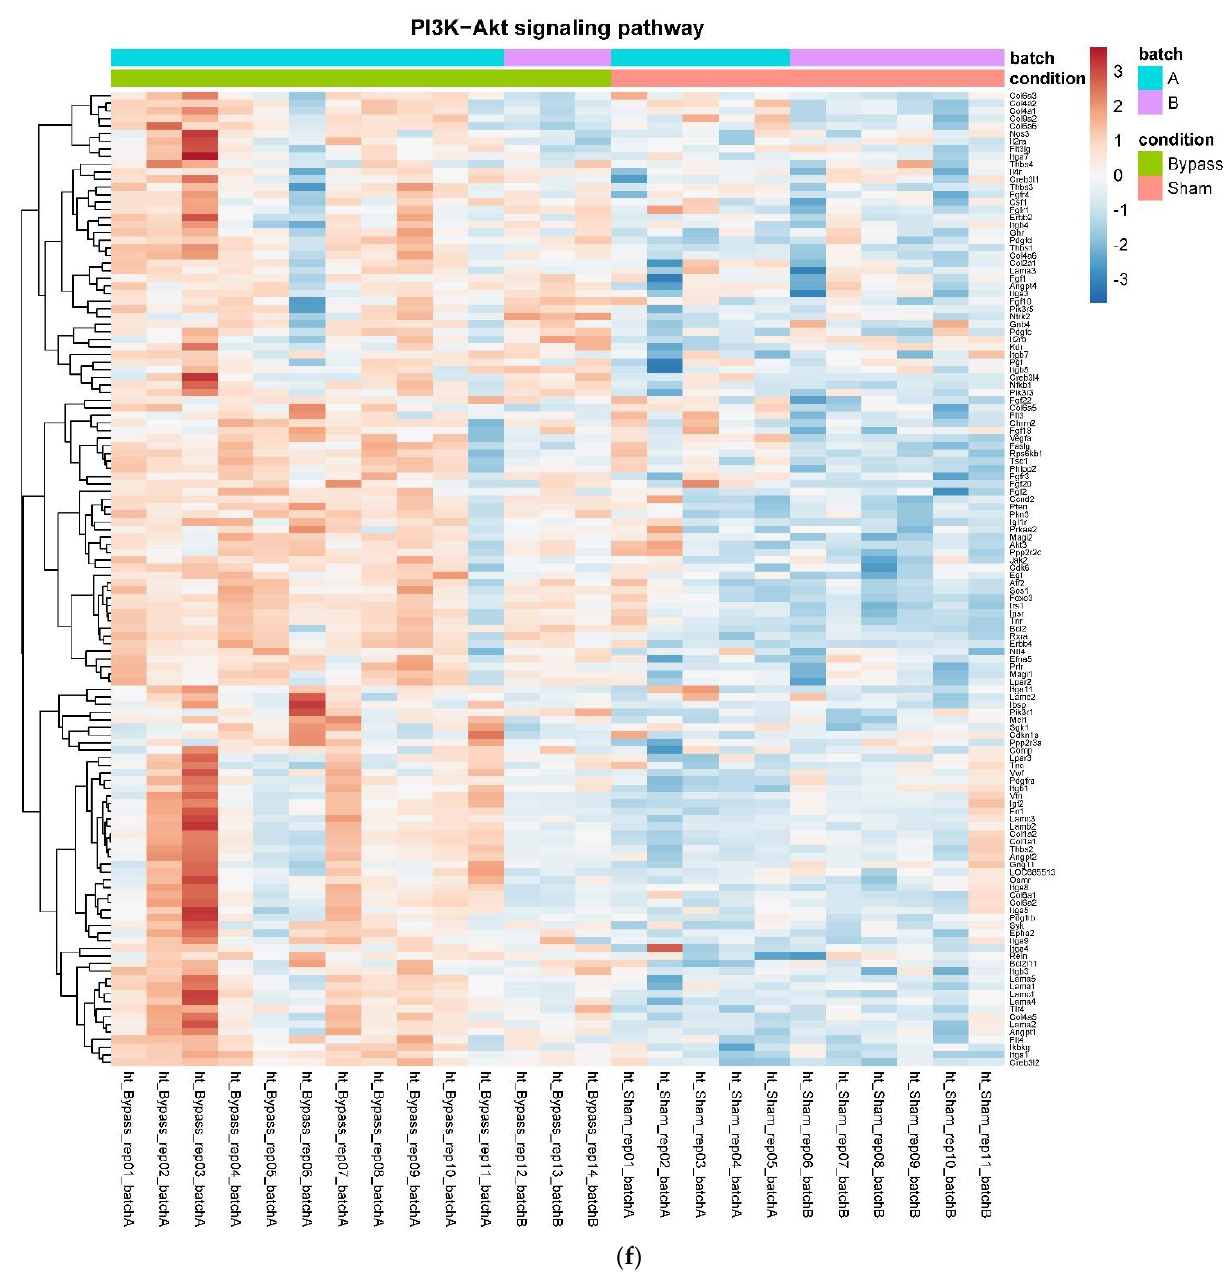
Figure 4. Heatmaps showing gene expression differences between treatment and control samples for the GSEA core enrichment of the pathways AMPK ( a , b ), JAK–STAT ( c , d ), PI3K–Akt ( e , f ) in BWM vs. sham and RYGB- vs. sham-treated animals. Analysis was performed based on DESeq2 log2 fold changes of all analyzed genes (without applying any filters). Expression values represent row-wise z-scores of vst-transformed read counts with higher expressed genes in red and lower expressed genes in blue. GESA, gene set enrichment analysis.